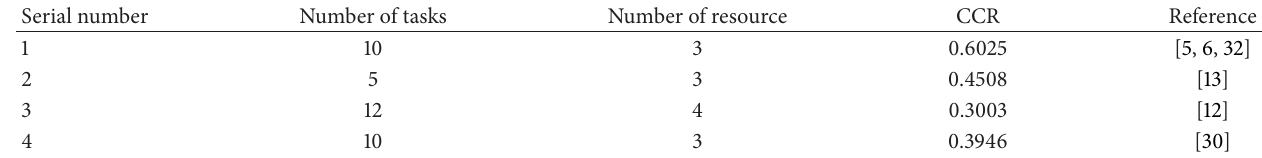
Table 5: Reference and related parameters for the sets of task graphs.